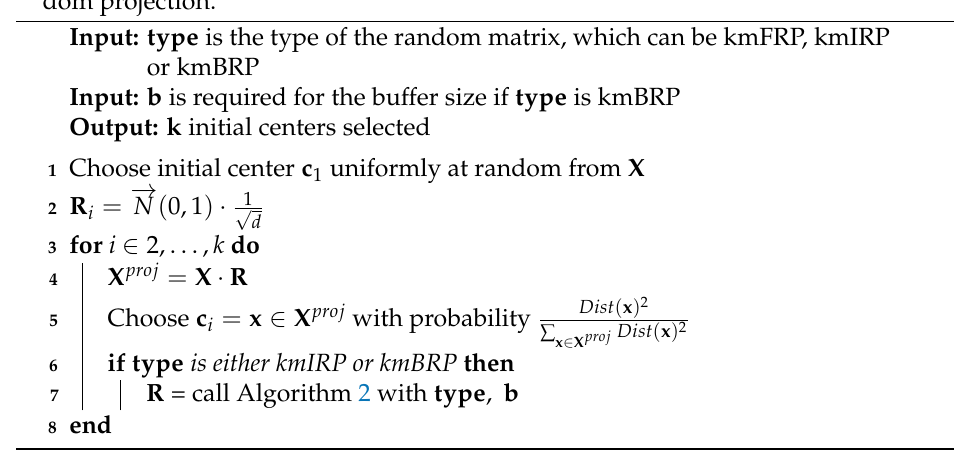
Algorithm 3: Proposed k-means++ approximation with different types of ran- dom